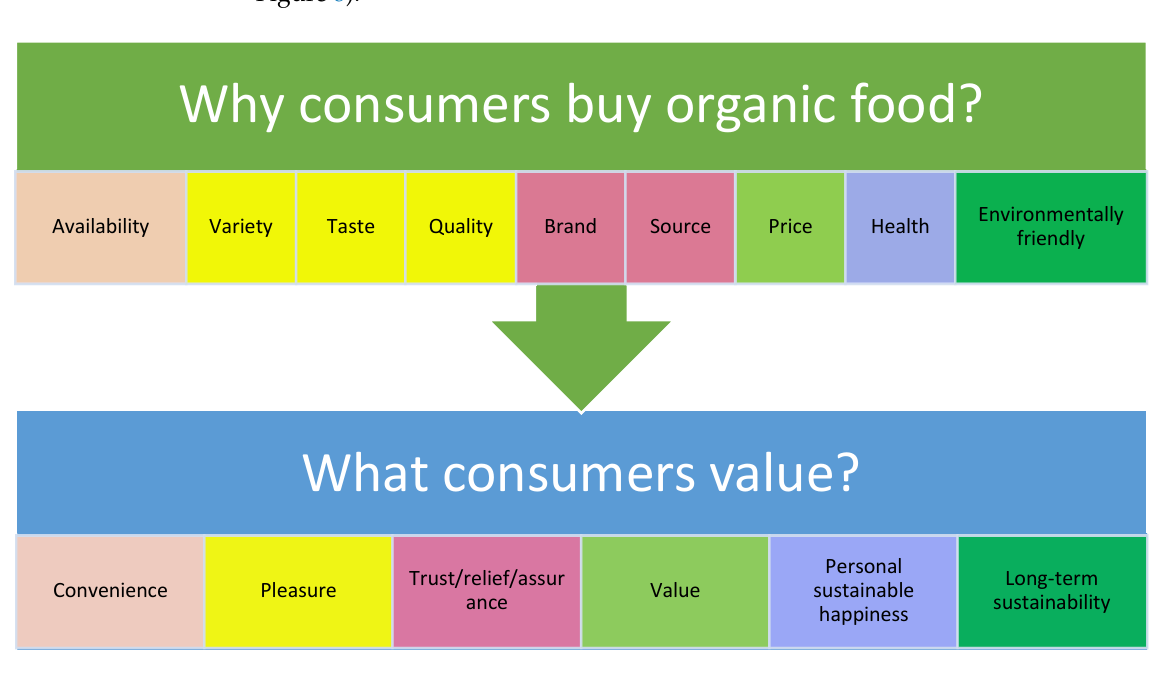
Figure 8. Features most valued by consumers.